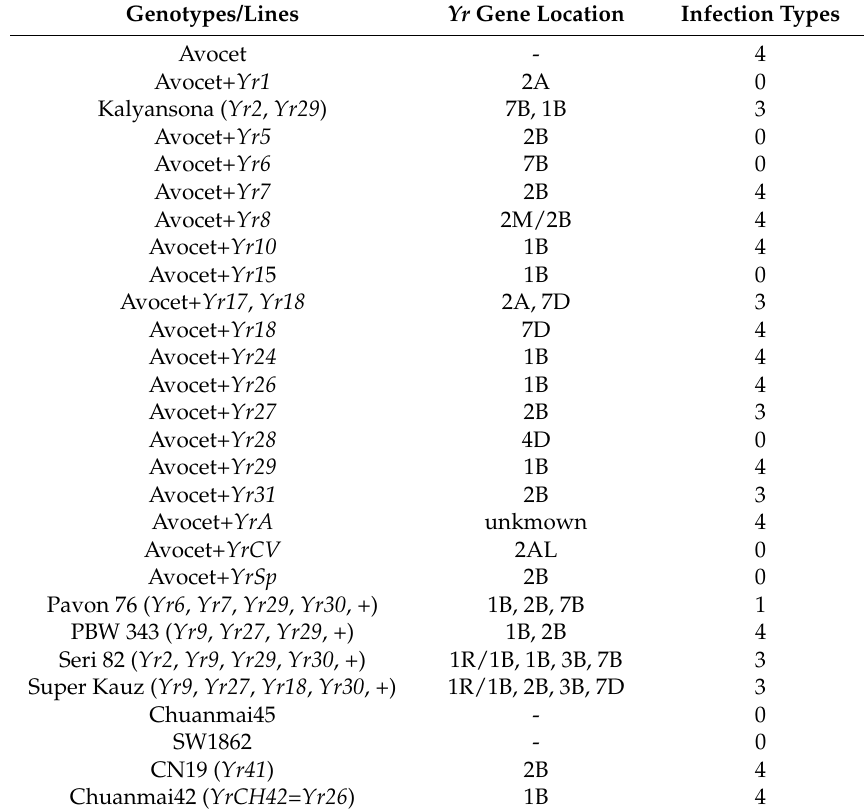
Table 1. Virulence testing of wheat stripe rust strain pathotype No. 09-6-16-3 on wheat stripe rust differential lines and parental lines at the seedling stage.